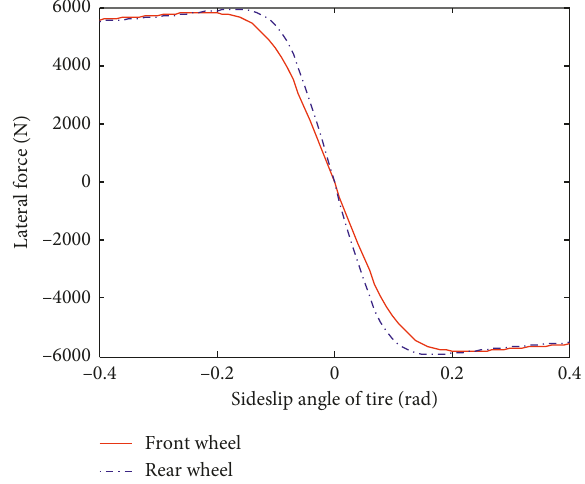
Figure 2: Cornering characteristics of